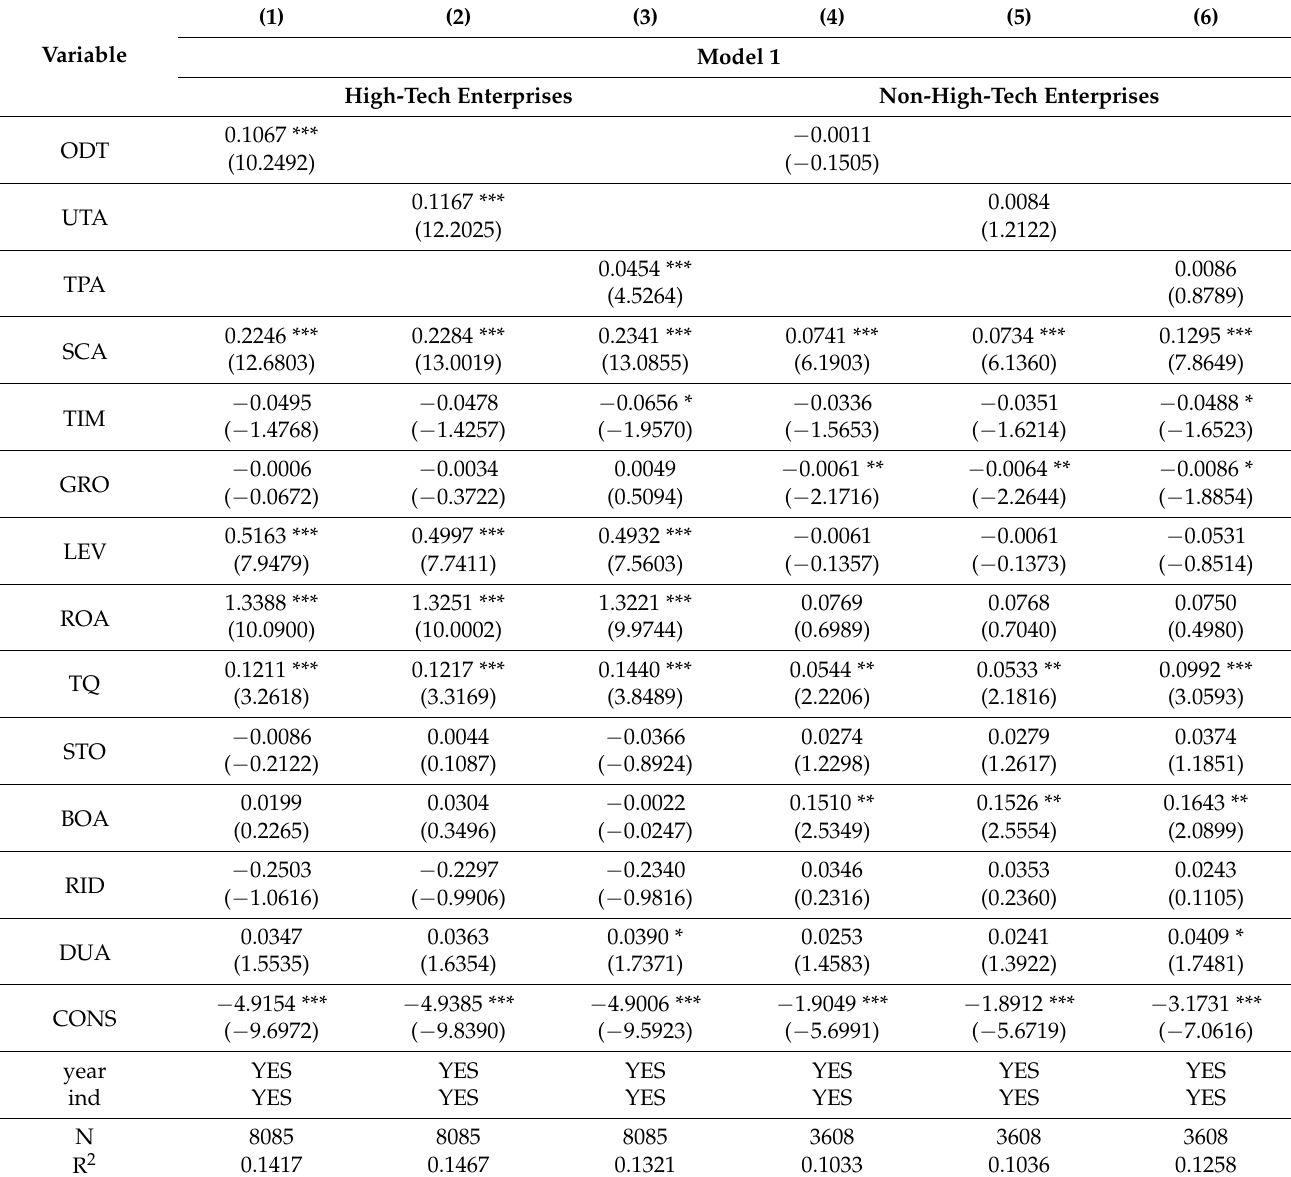
Table 9. Group test results according to whether high-tech enterprises or